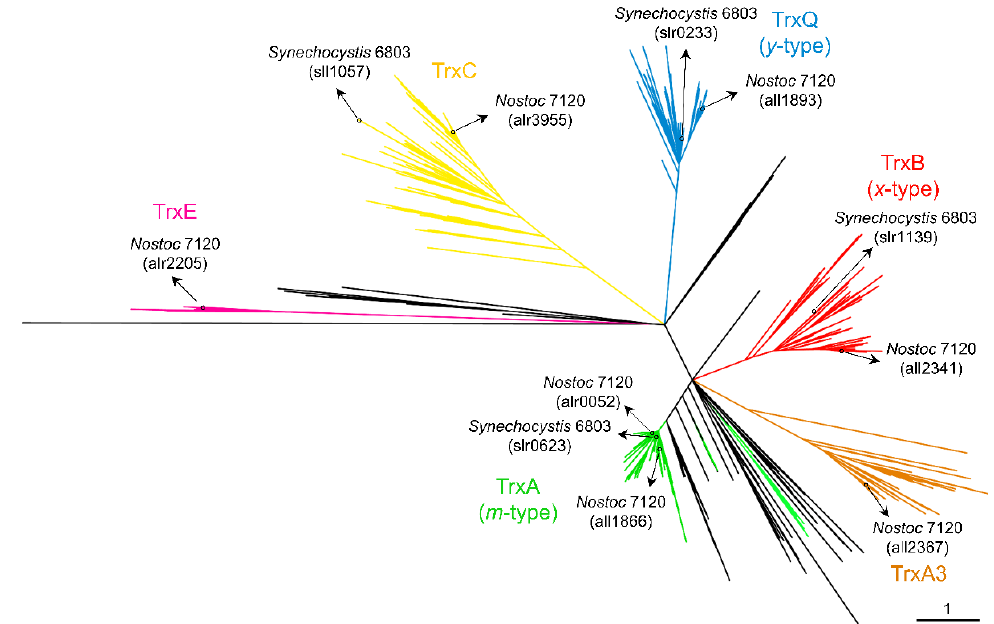
Figure 1. Phylogenetic distribution of cyanobacterial thioredoxins. Unrooted tree of full-length Trx amino acid sequences identified in the IMG and NCBI databases. Branches are colored to represent proteins found in the different subclades: TrxA1/2 (green), TrxA3 (brown), TrxB (red), TrxQ (blue), TrxC (yellow), and TrxE (purple). The scale bar represents the number of substitutions per site. Branches related to Melainabacteria, Sericytochromatia, and Margulisbacteria are colored black.